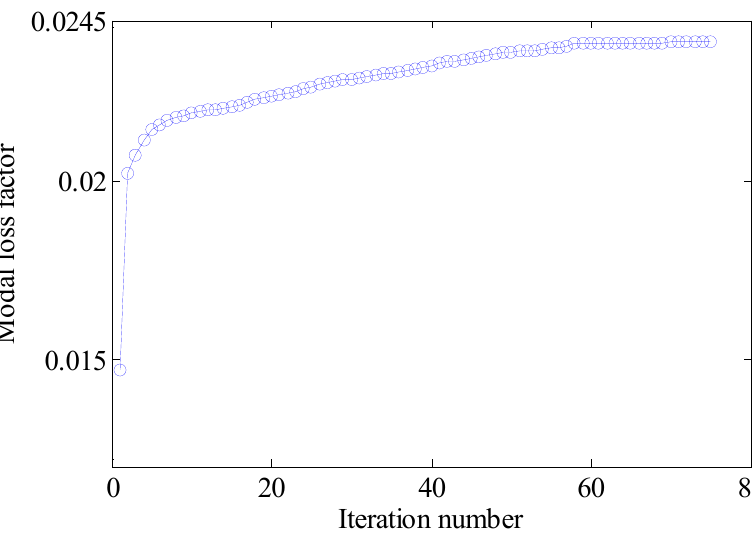
Figure 11. Iteration histories for initial guess design 2 .